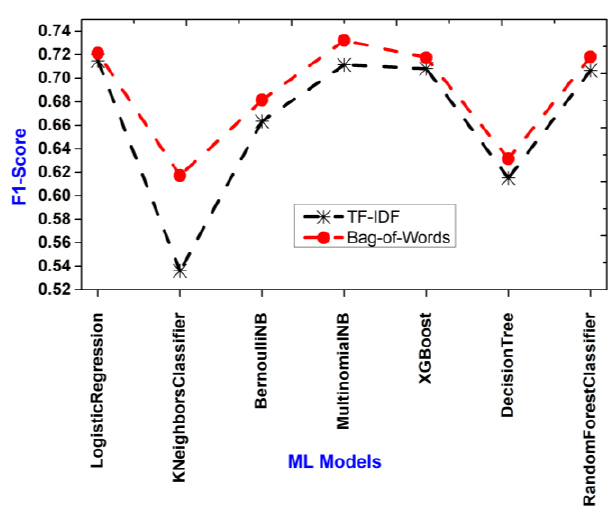
Fig. 4. F1-score for a dataset (Coursera Reviews) using seven ML algorithms with TF-IDF and bag of